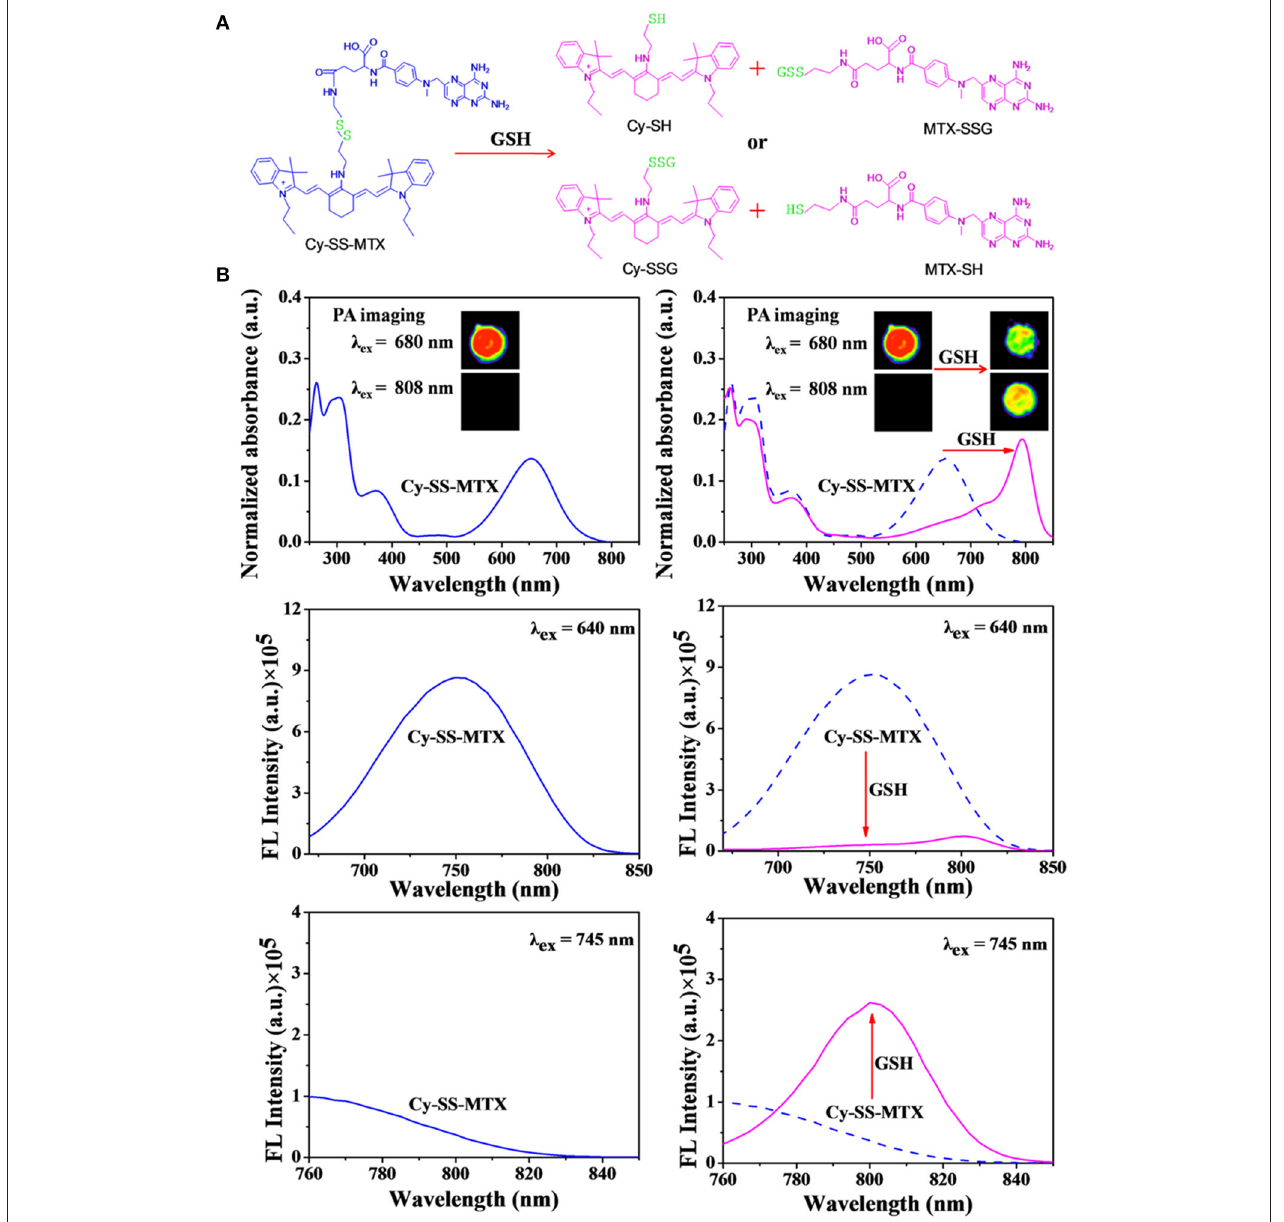
FIGURE 1 | (A) Schematic the two ways of GSH activation in theranostic prodrug Cy-SS-MTX in cancer cells. (B) The changes in PA imaging, UV-Vis absorption and fluorescent characteristics of Cy-SS-MTX in the presence of GSH or not. The PA imaging upon excitation at 680/808nm and fluorescence characteristics upon excitation at